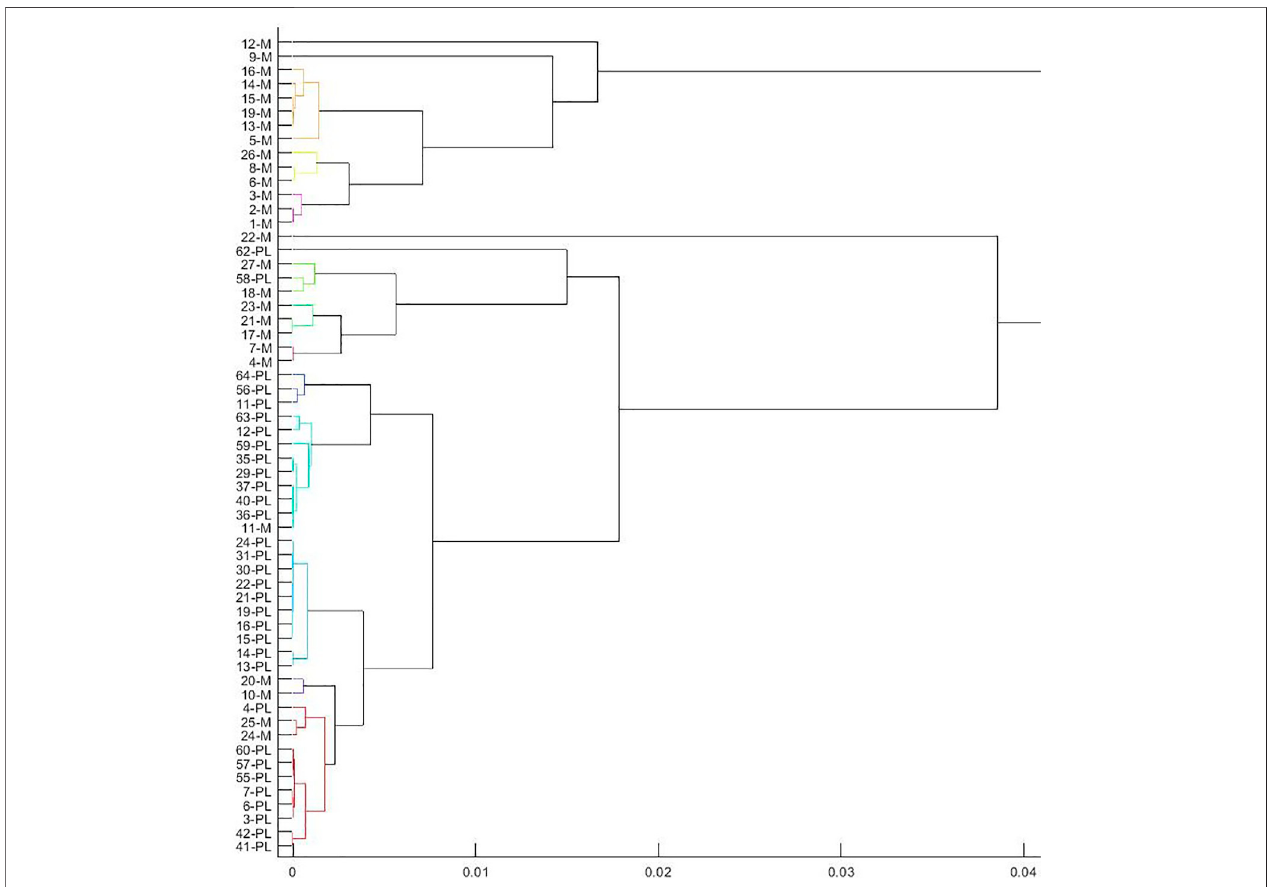
FIGURE 6 | Clusters obtained from the hierarchical clustering tree by using the average linkage.